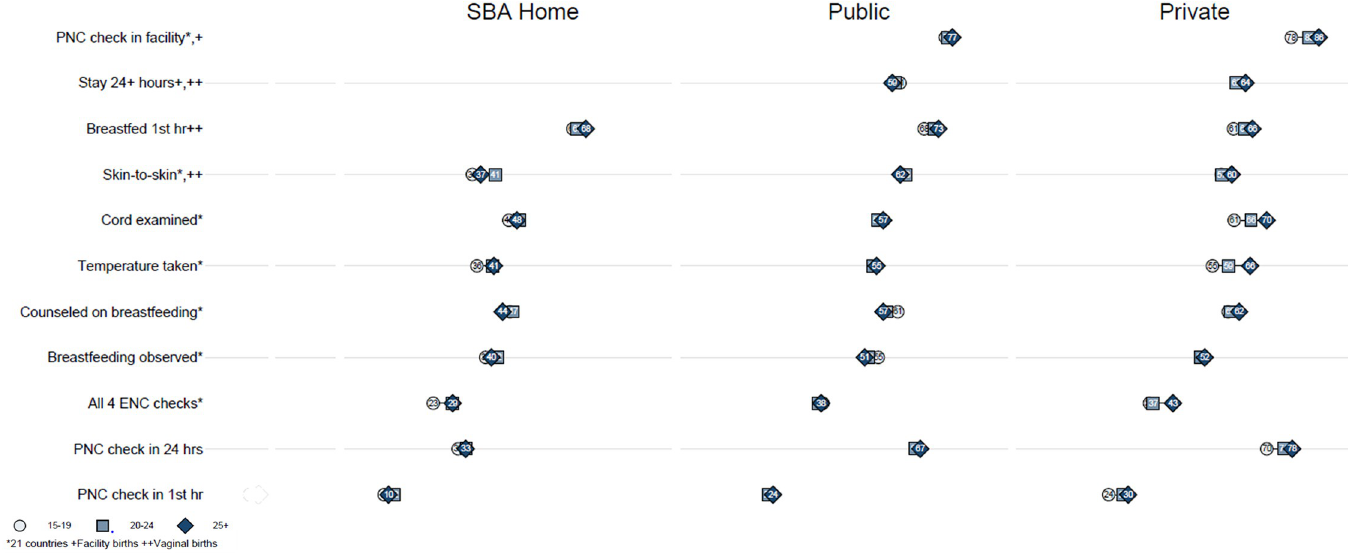
Fig 3. Receipt of PNC and ENC by maternal age and place of delivery.